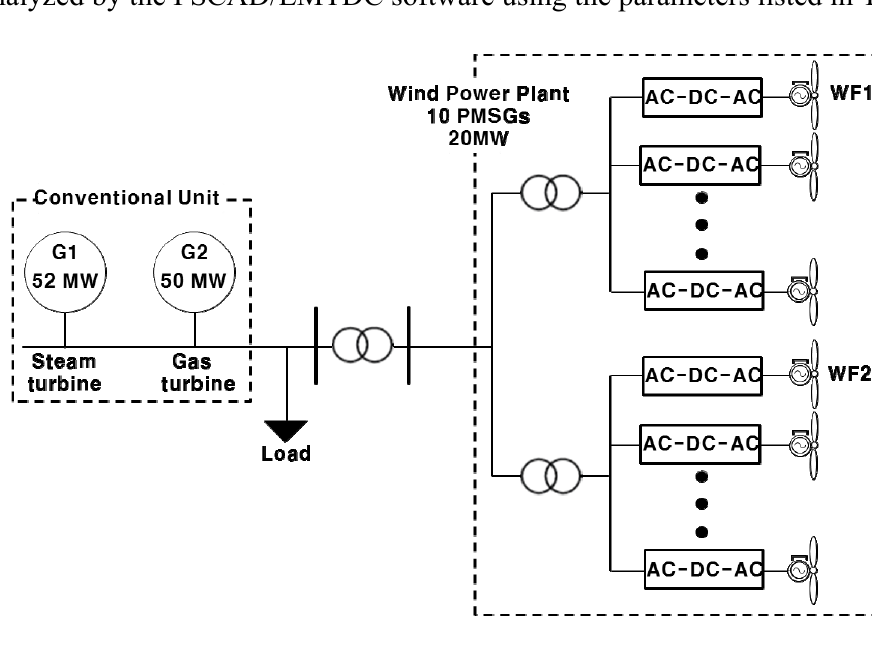
Figure 10. Configuration of the small power system. Table 1. PMSG wind turbine generator